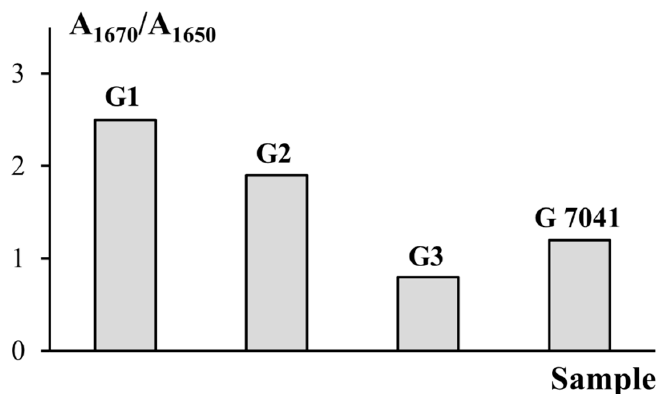
Figure 4. The ratios of the integral intensity of the peaks corresponding to triple helixes (A1670) and random coils (A1650) in the second derivative spectra of fish gelatin.